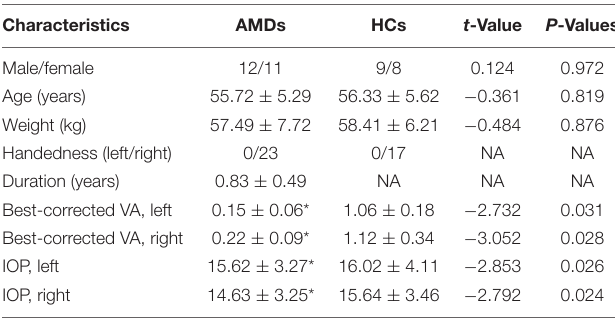
TABLE 1 | Clinical characteristics of patients between AMDs and